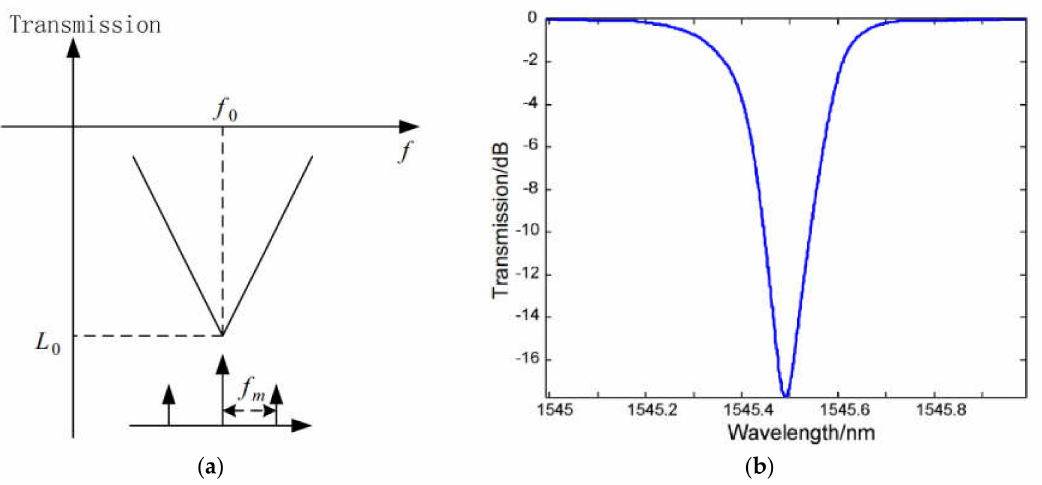
Figure 9. IFM method using a triangular V–shaped filter: ( a ) Characteristics of the V–shape filter; ( b ) Transmission spectrum of the fabricated fiber Bragg grating (Reprinted with permission from Ref [45]. Copyright 2010,